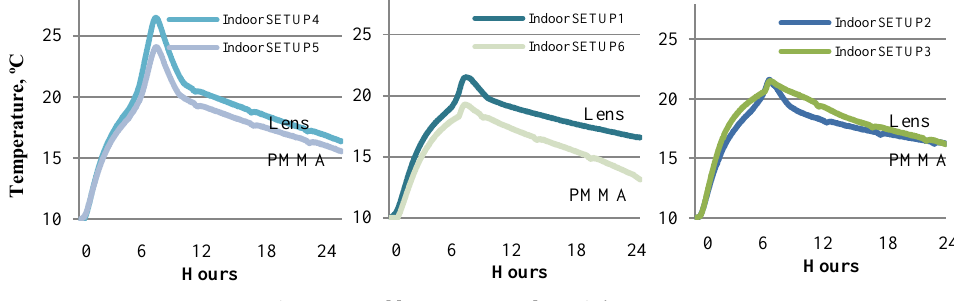
Fig. 10. Fresnel lens vs PMMA glass – indoor